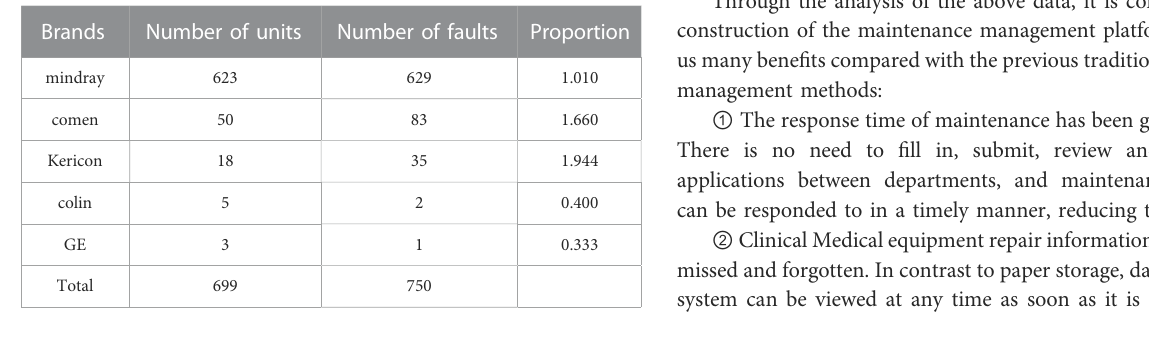
TABLE 2 The number of failures of each brand monitor.